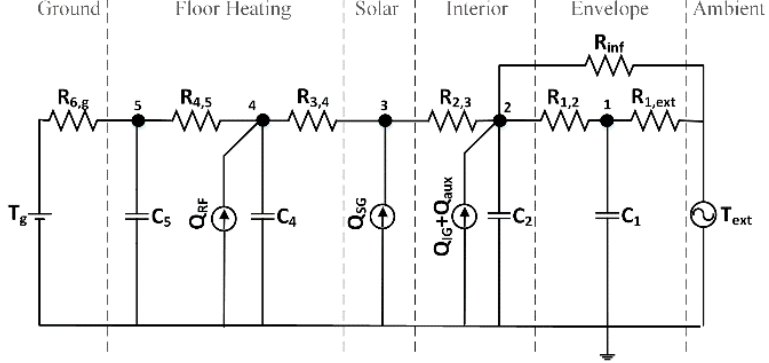
Figure 13. RC thermal network model of the zones with hydronic radiant floor system and convective system. The performance of the simplified RC model is validated with measured data, as shown in Figure 14.